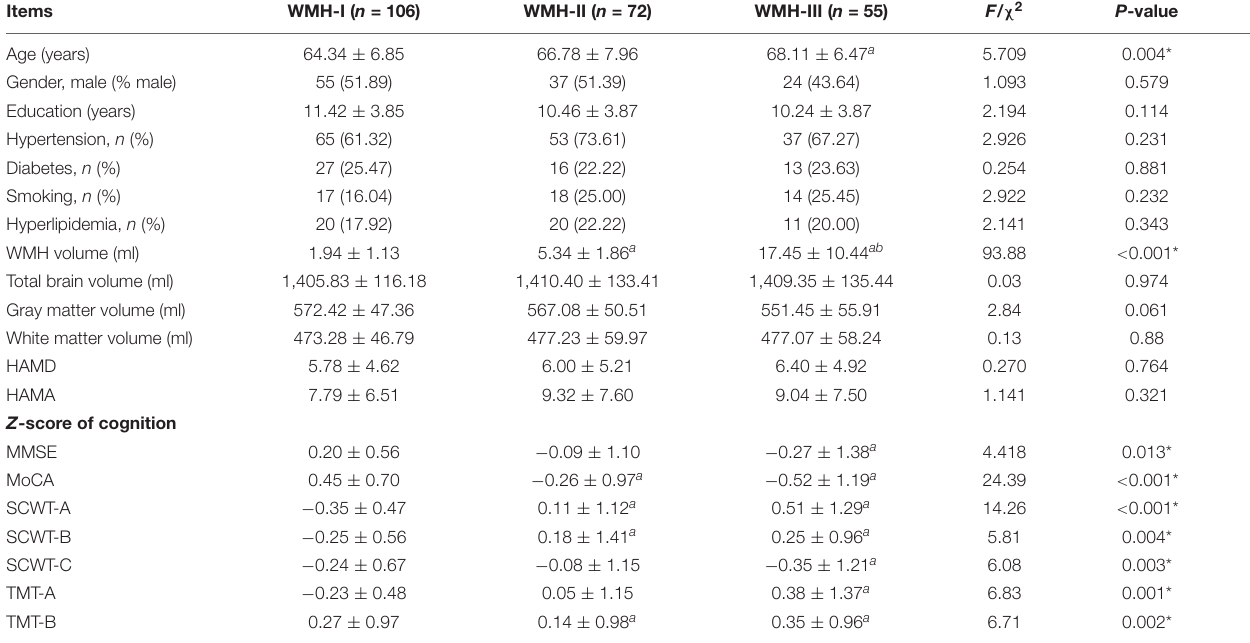
TABLE 1 | Basic characteristics and cognitive evaluations among the three